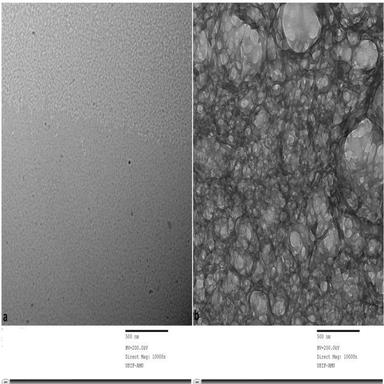
Transmission electron microscopy. TEM analysis of (a) native hTF and hTF incubated with 50 mM MG for 12 days.